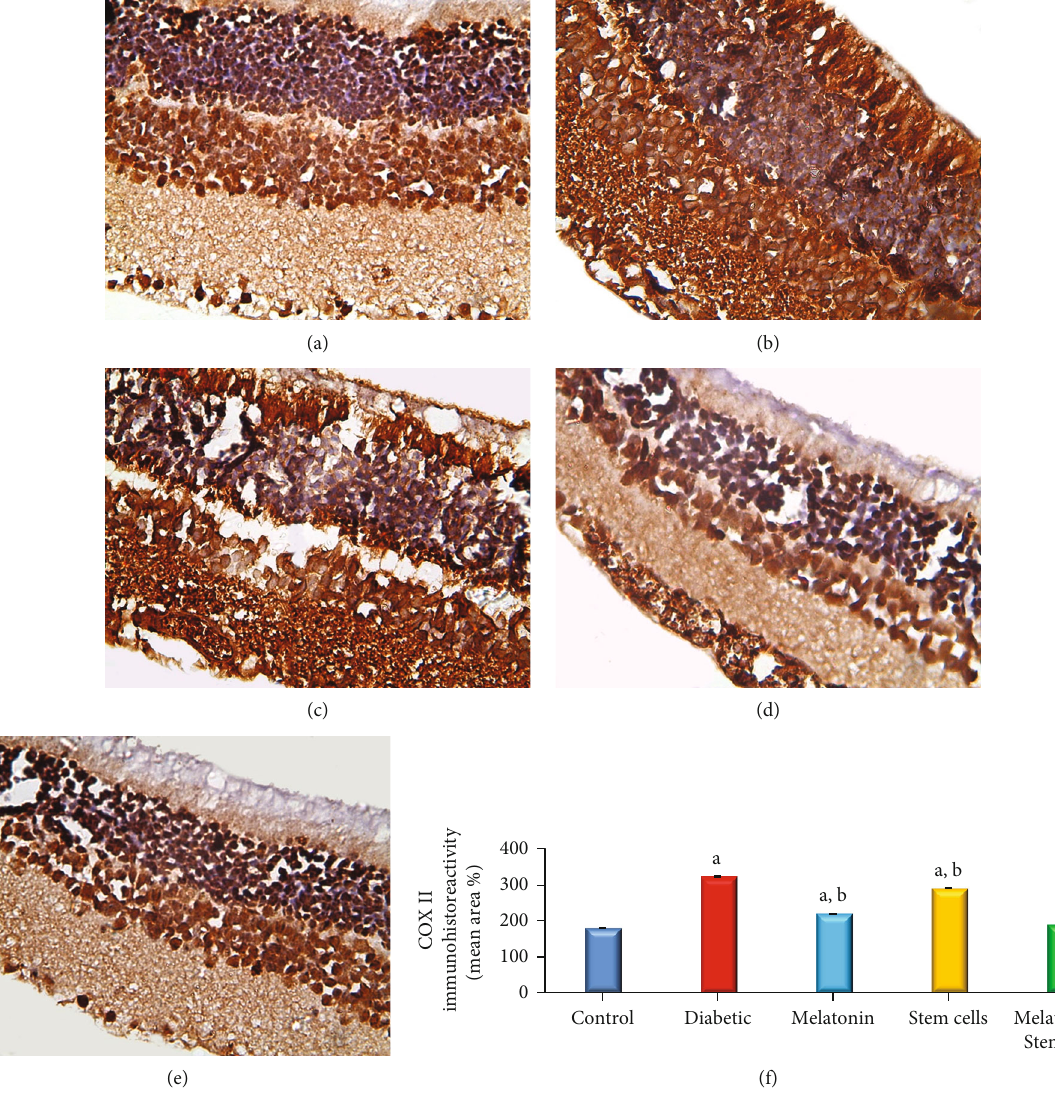
Figure 5: Photomicrograph of COX-II immunohistochemically stained retinal sections (magni fi cation, × 200). (a) Control group showed no immunoreactivity. (b) Diabetic group showed a strong positive COX-II immunoreactivity (brown color). (c, d) Melatonin and stem cell groups, respectively, displayed a positive immunoreactivity (brown color). (e) The melatonin+stem cell group showed a negative immunoreactivity. (f) The optical density of COX-II was represented as means ± SE ( n = 10 ). a indicates a signi fi cant di ff erence as compared to the control group at P < 0 : 05 . b indicates a signi fi cant di ff erence as compared to the diabetic group at P < 0 : 05